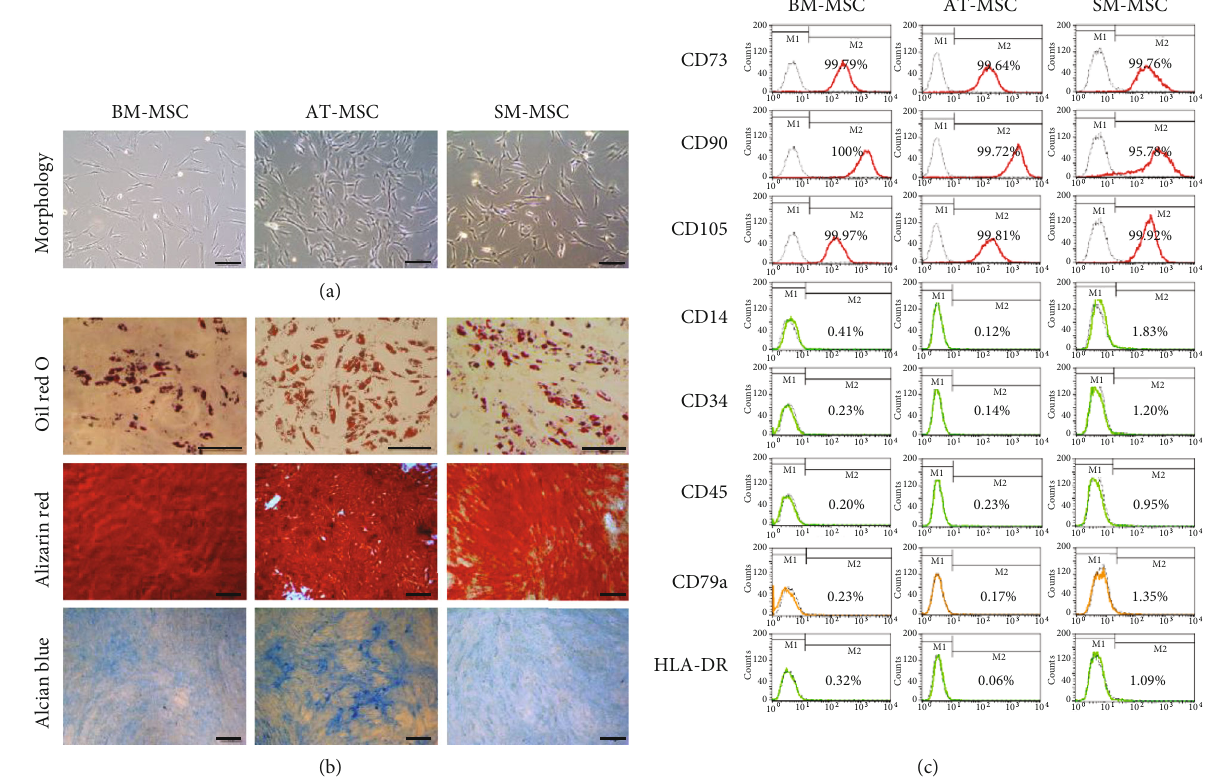
Figure 1: Representative characterization of bone marrow (BM), adipose tissue (AT), and synovial membrane (SM) mesenchymal stem cells (MSCs). (a) Phase-contrast microscopy images of MSCs (scale bar = 100 μ m ). (b) Di ff erentiation potential of MSCs. Adipogenic di ff erentiation (Oil Red O, top), osteogenic di ff erentiation (Alizarin Red S, middle), and chondrogenic di ff erentiation (Alcian Blue, bottom). (c) The immunophenotyping of MSCs using fl ow cytometry. Positive (CD73, CD90, and CD105) and negative (CD14, CD34, CD45, CD79a, and human leukocyte antigen-DR (HLA-DR)) markers. The histogram is shown with an overlay isotype